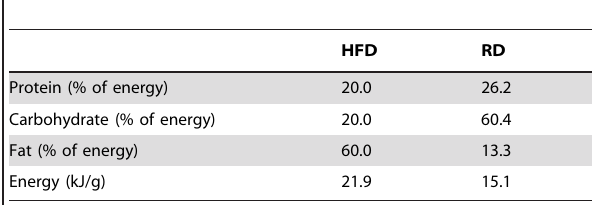
Table 1. Composition of high fat diet (HFD) and regular diet